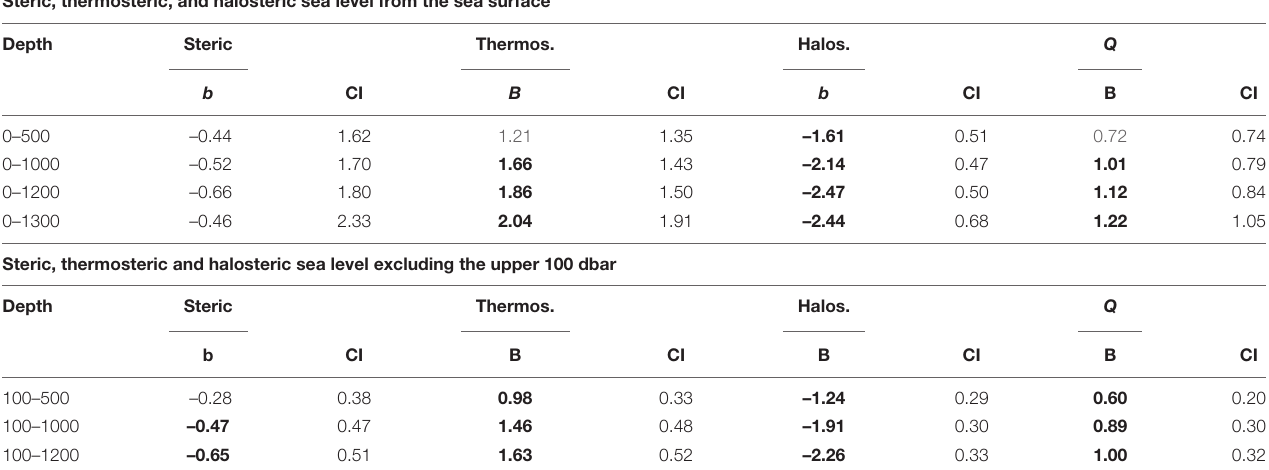
TABLE 3 | Linear trends for the steric sea level, thermosteric sea level, halosteric sea level (b, mm/yr), and heat absorbed by a water column of one square meter (W/m 2 ). Steric, thermosteric, and halosteric sea level from the sea surface Depth Steric Thermos. Halos. Q